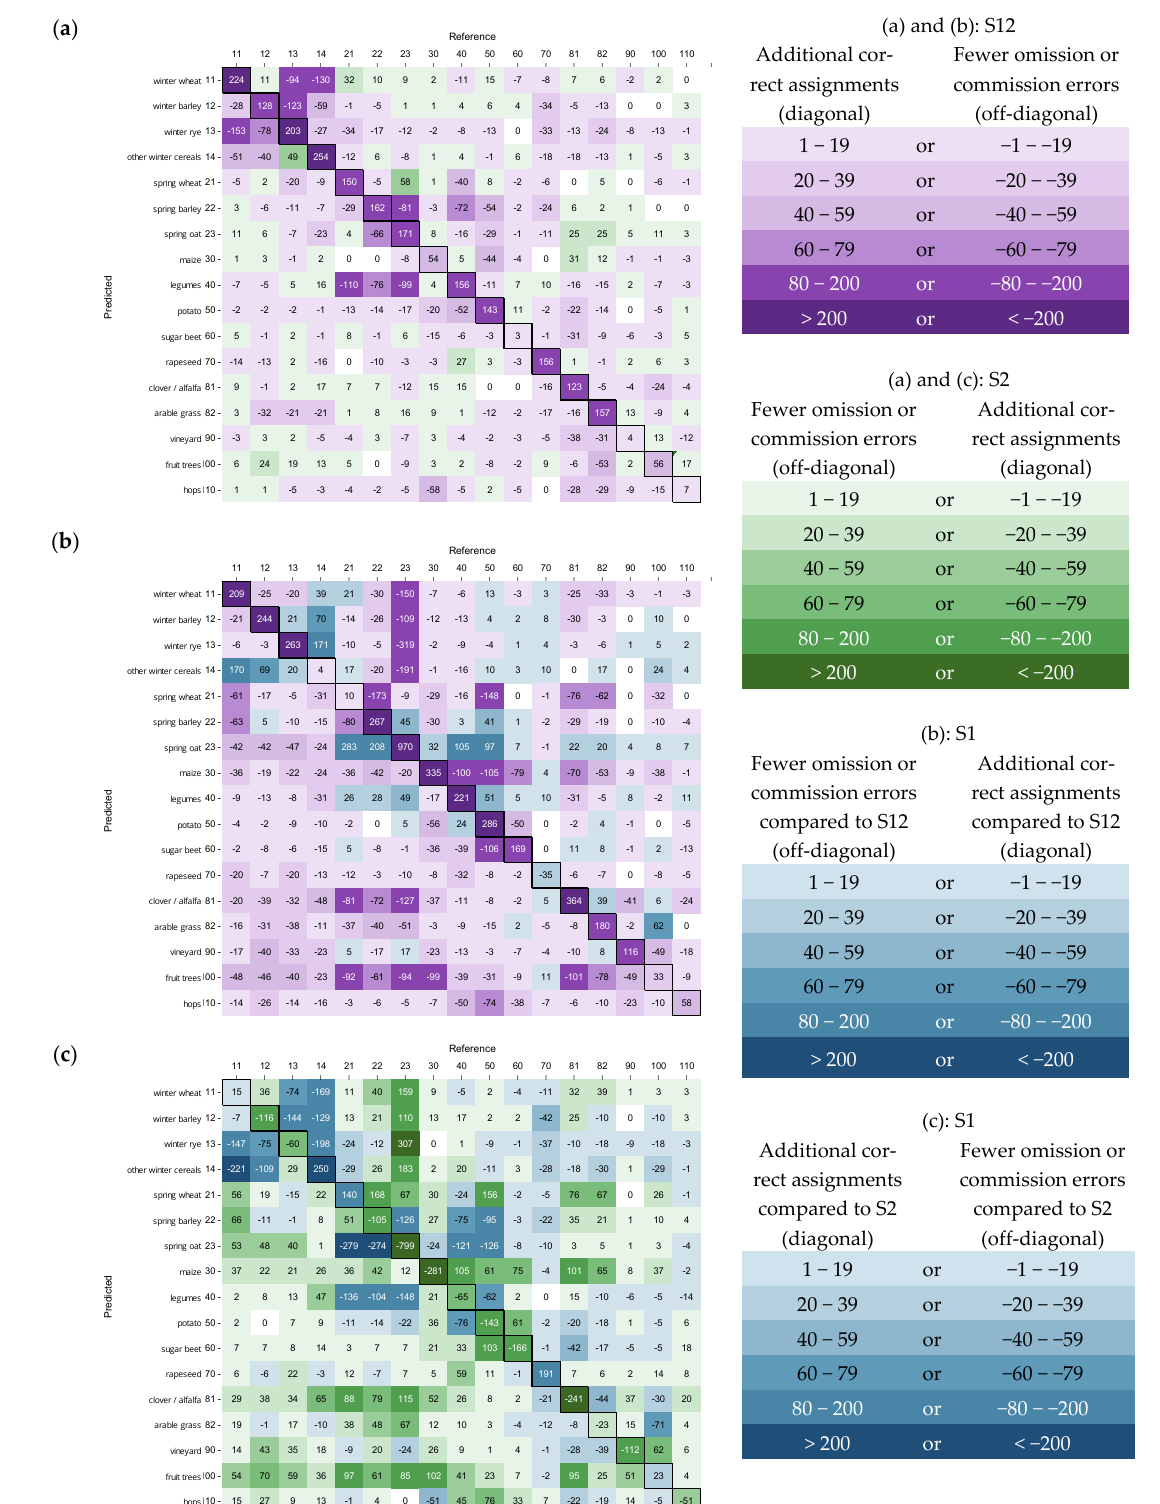
(nevertheless lower) omission error, resulting in an overall slightly lower number of cor- rect assignments.